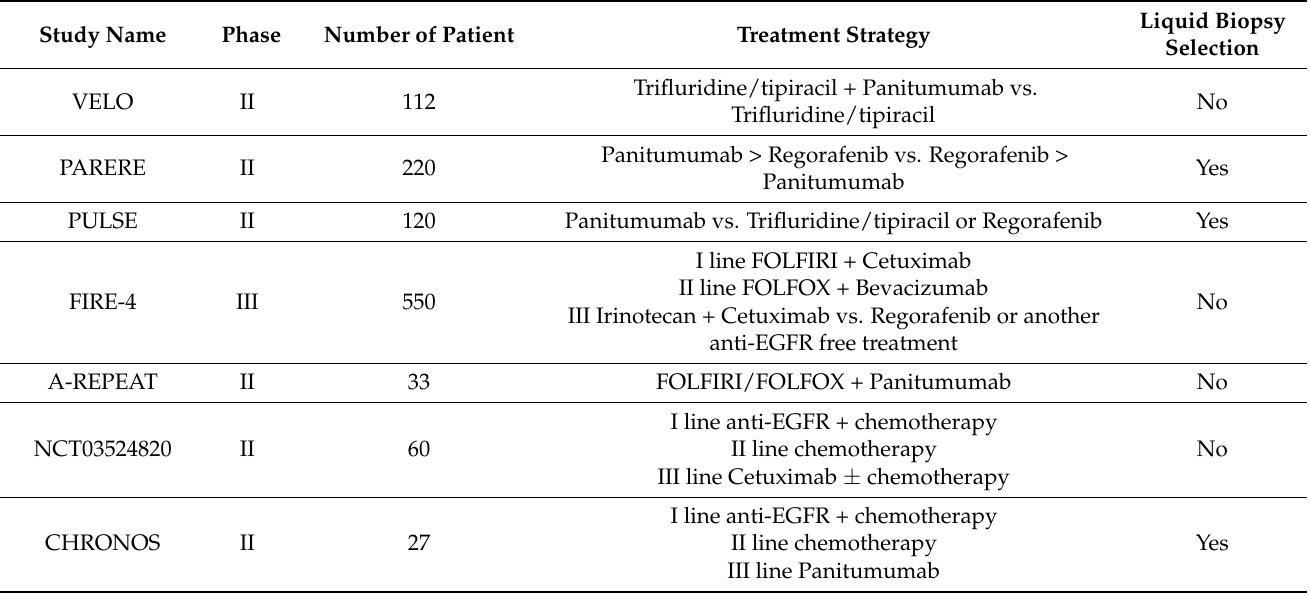
Table 2. Rechallenge with anti-epidermal growth factor ongoing